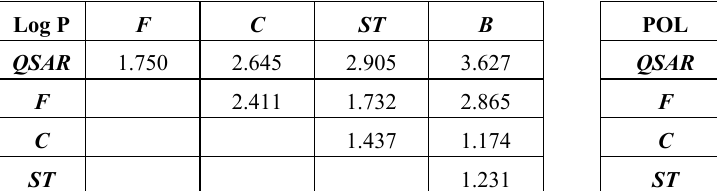
 of the QSAR and catastrophe models’ relative statistics of Table 5 I